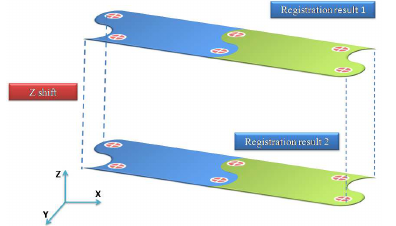
Fig. 12. Case of shift in Z axis. FB-Evaluation cannot return correct evaluation results. In fact the score returned by FB- Evaluation of those two registration result is the same despite the Z axis